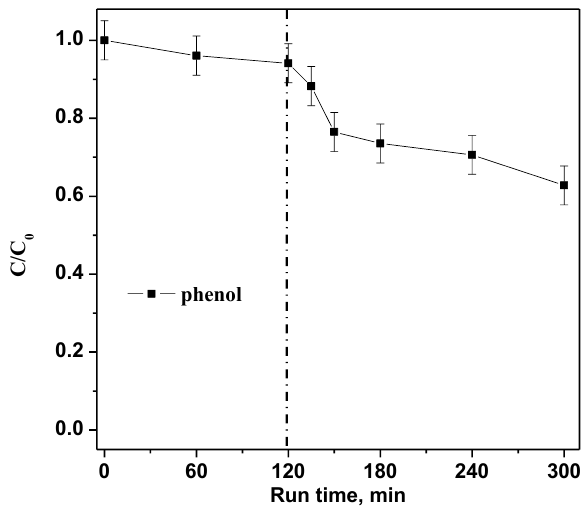
Figure 15. Photocatalytic discoloration of an aqueous solution containing phenol (10 mg L − 1 ) with the RM_2.5Fe photocatalyst under visible (white) light irradiation.